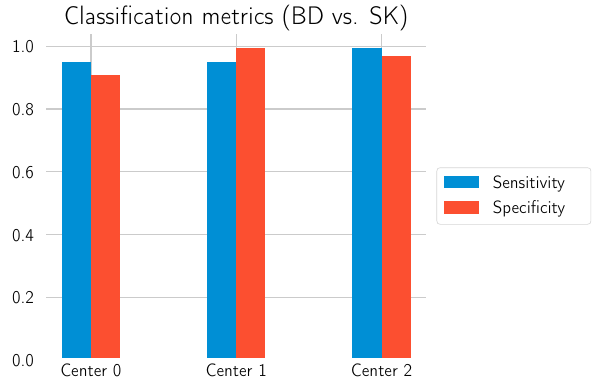
Figure 11. Sensitivity/specificity on the test datasets for the call “BD vs.